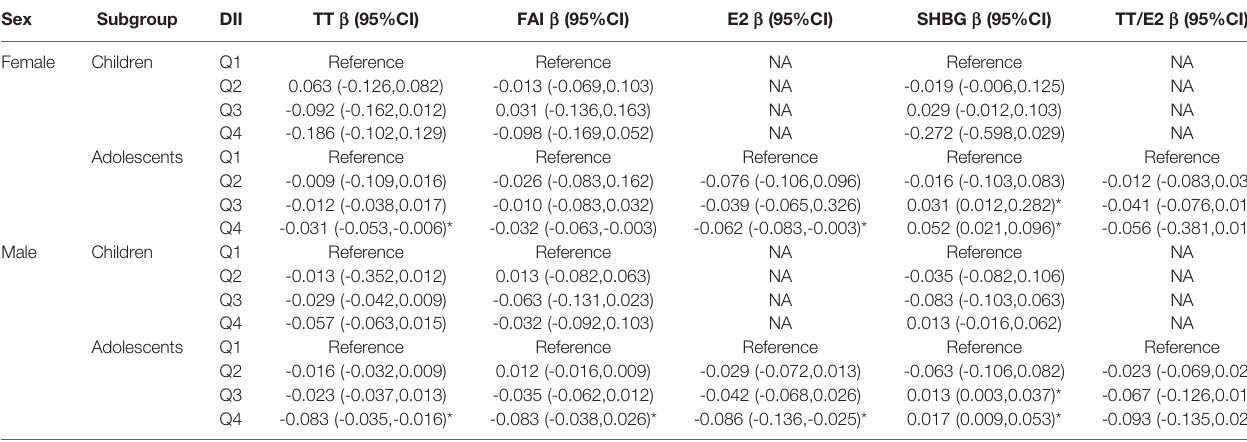
TABLE 3 | Association between categorical dietary in fl ammatory index (DII) and sex hormones by sex-age groups in 6-19-year old participants in NHANES 2015-2016. Sex